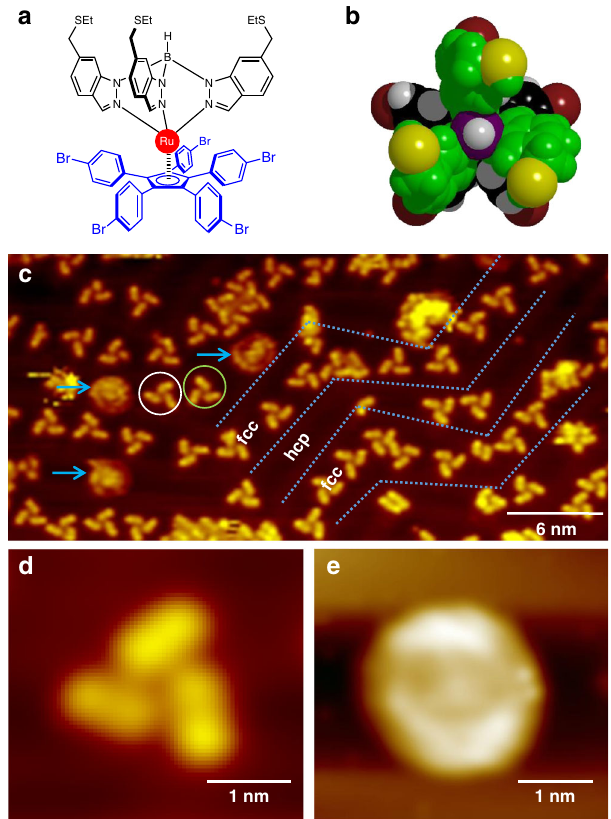
Fig. 1 Shape and structure of the molecular propeller. a Chemical structure of the molecule. b Top view of the ball and stick model of the molecule. color code: Dark red = Br, gray = H, black = C atoms on the Cp(PhBr) 5 , violet = B, yellow = S, green = other atoms on the indazole fragments (ethyl groups are omitted for clarity). c A large area STM image of molecular propellers on Au(111) at 80 K. Tripod structures are stationary. Blue arrows point to rotating propellers. Gray dashed lines highlight the herringbone structure of Au(111). STM images showing a stationary ( d ) and rotating molecular propeller ( e ). [STM imaging parameters for c , d , and e : V t = − 1 V, I t = 70